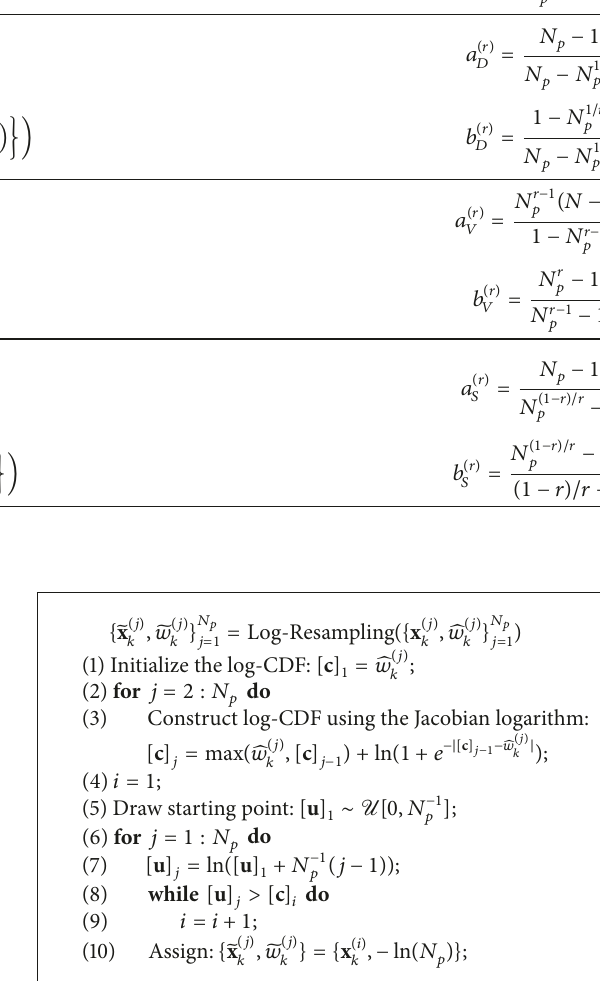
Algorithm 3: Generic-PF in log-domain (Generic Log-PF).